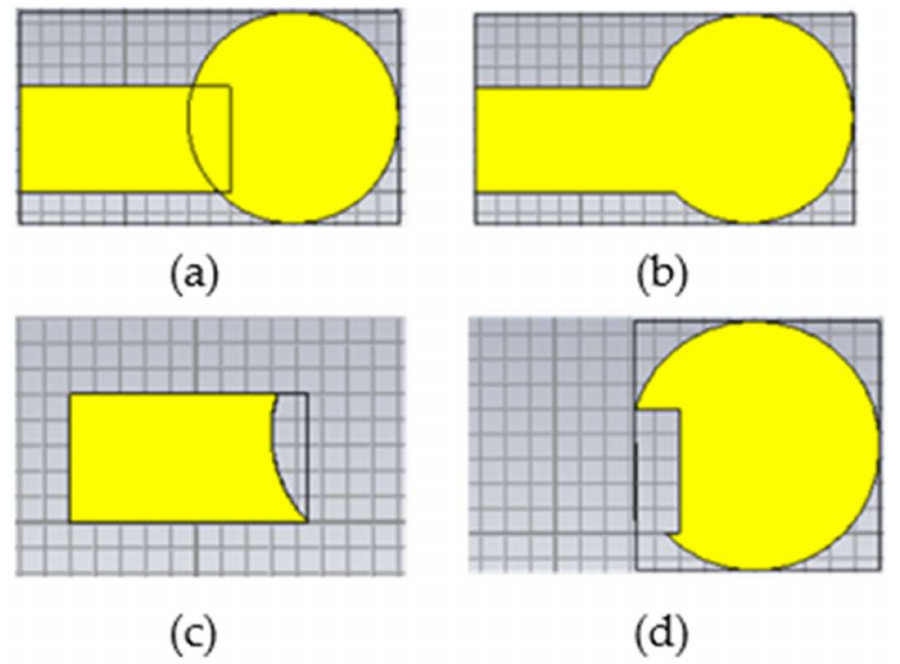
Figure 1. In ( a ), the intersection and two components; the summation operation is shown in ( b ). In ( c ), the second material is subtracted from the first. In ( d ), the first material is subtracted from the second. For the creation of each shape, a total of x materials can be created and there is the total of y region of intersections. Based on the intersection regions, shapes can be created with the possibility of 3 y . A component can have more than one intersection region. Some other intersection regions may disappear when the subtraction is done in any order. Therefore, different shapes may occur depending on the process priority of the intersection